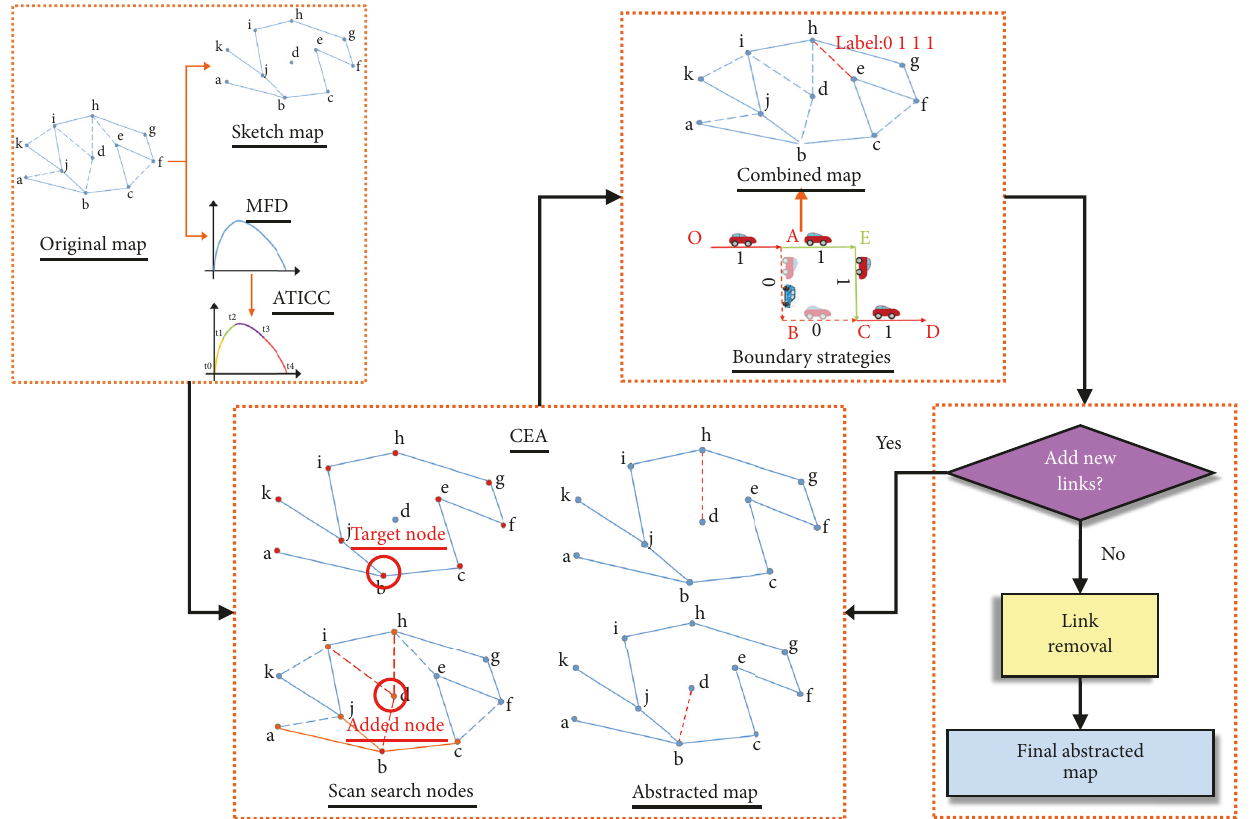
Figure 6: Workflow of the spatiotemporal dynamic map abstraction